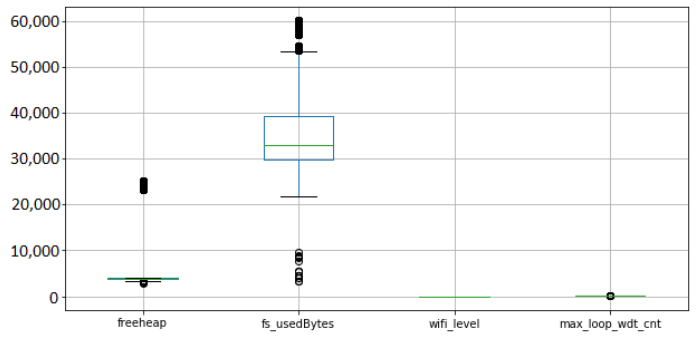
Figure 16. Summary of the four ESP8266 metrics.